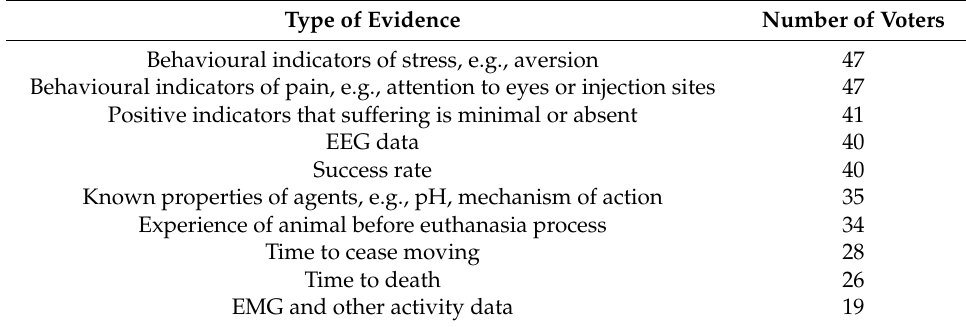
Table 2. Types of “scientific evidence” that meeting participants considered acceptable for making decisions about the humaneness of a method for